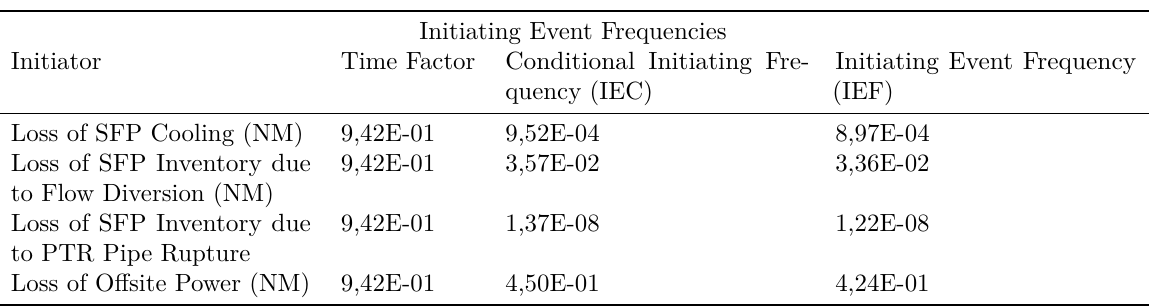
Table 1. Summary of Initiating Event Frequencies.